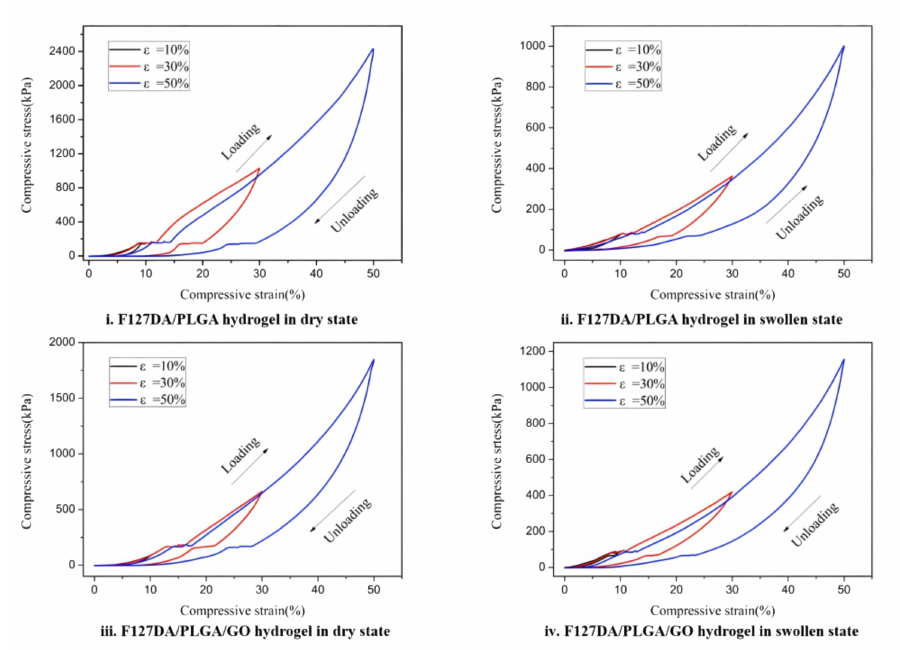
Figure 17. Compressive σ versus ε curves for F127DA/PLGA and F127DA/PLGA/GO hydrogels in dried state and F127DA/PLGA and F127DA/PLGA/GO hydrogels in swollen state. Reprinted with permission from Ref. [132]. Copyright 2019, Dai,